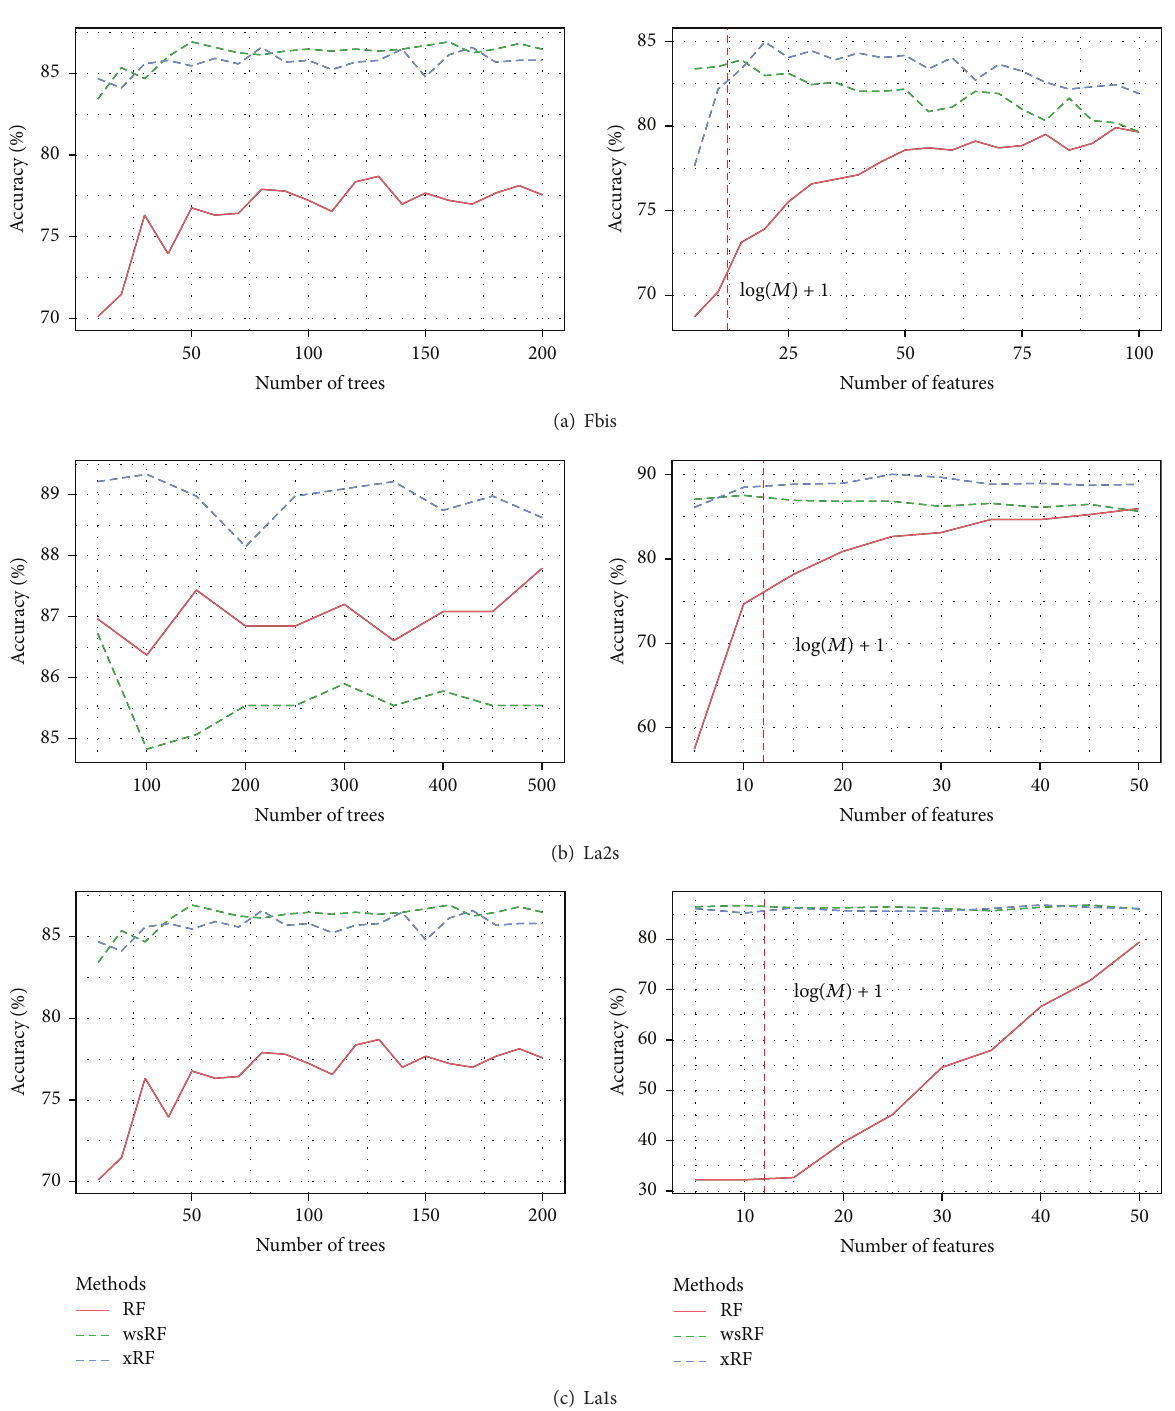
Figure 9: The accuracy of prediction of the three random forests models against the number of trees and features on the three